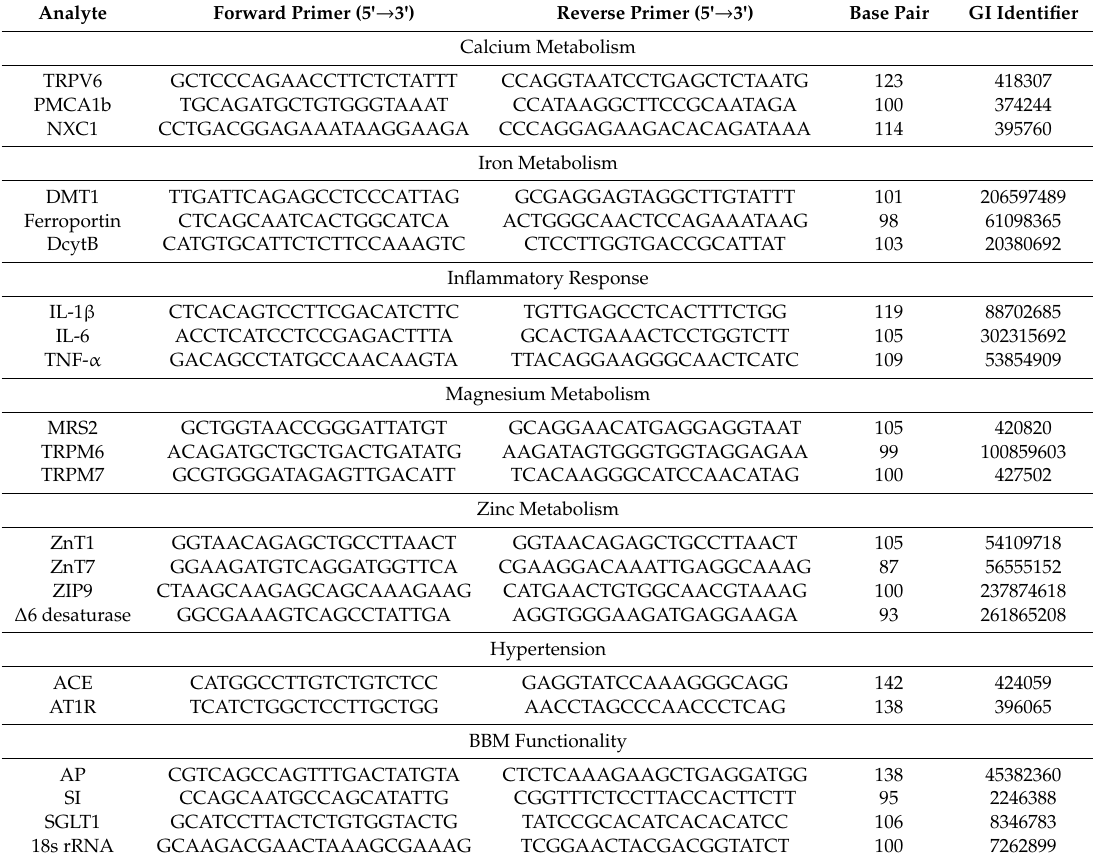
Table 1. DNA Sequences of the primers used in this